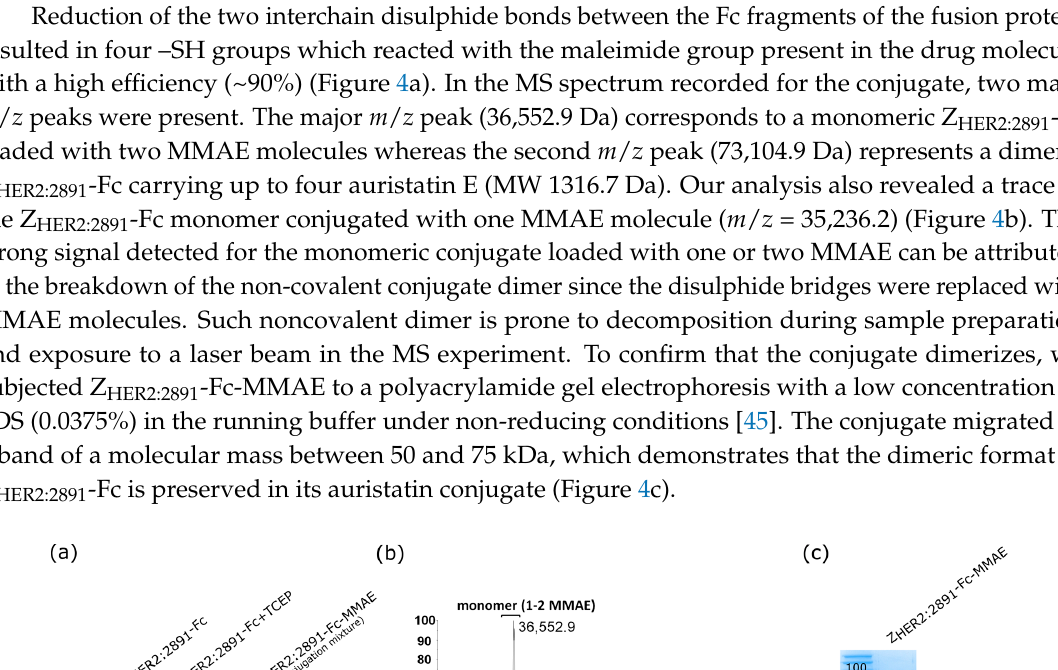
Figure 3. Specificity of the Z HER2:2891 -Fc binding. ( a ) Fluorescent microscopy images of the HER2-positive SK-BR-3 and MDA-MB-231 HER2-negative cells. The anti-HER2 antibody was detected with a FITC-labeled secondary antibody whereas the affibody was FITC labelled, scale bar = 100 µm; ( b ) Z HER2:2891 -Fc binding to the SK-BR-3 and MDA-MB-231 cells analyzed by Western blotting. The upper panel shows HER2 levels in SK-BR-3 and MDA-MB-231cells, the middle panel severs as a loading control for the experiment, the bottom panel demonstrates that Z HER2:2891 -Fc is specifically enriched at the surface of the SK-BR-3 cells.